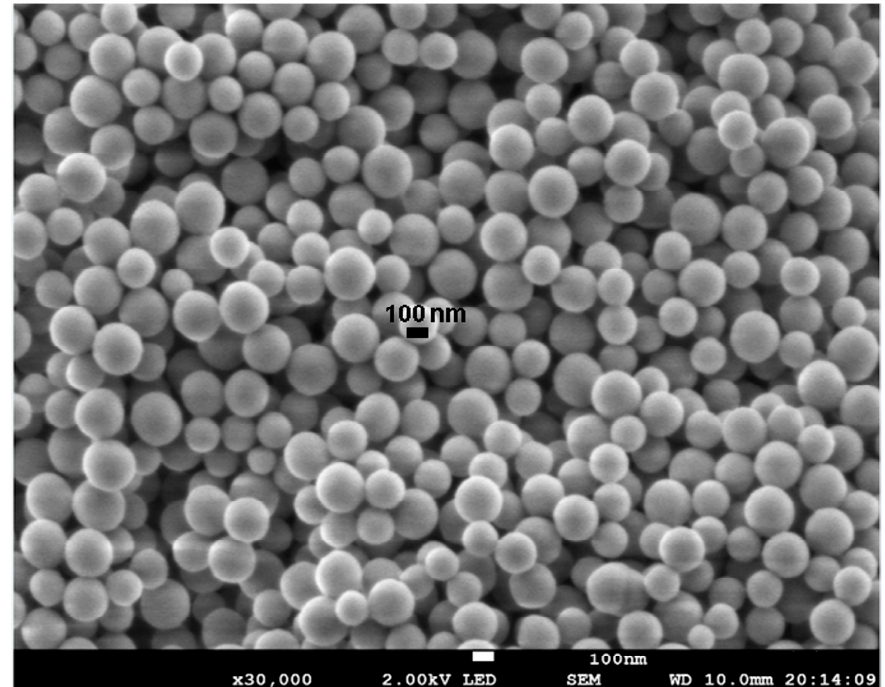
Figure 3. Morphological characterization of the first stage of synthesis of silica nanoparticles by scattering electron microscopy. Nanoparticles are spherical, with a diameter of ~140 nm, and are homogeneous.